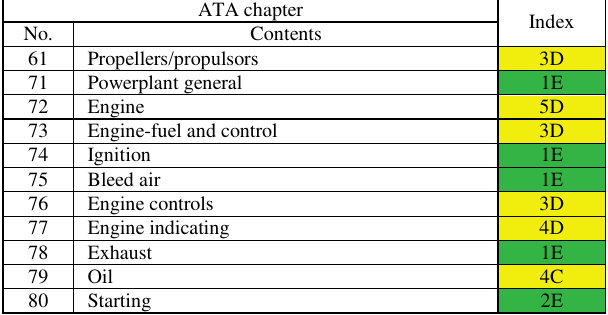
Table 10. Safety risk assessment matrix for turboprop engine systems